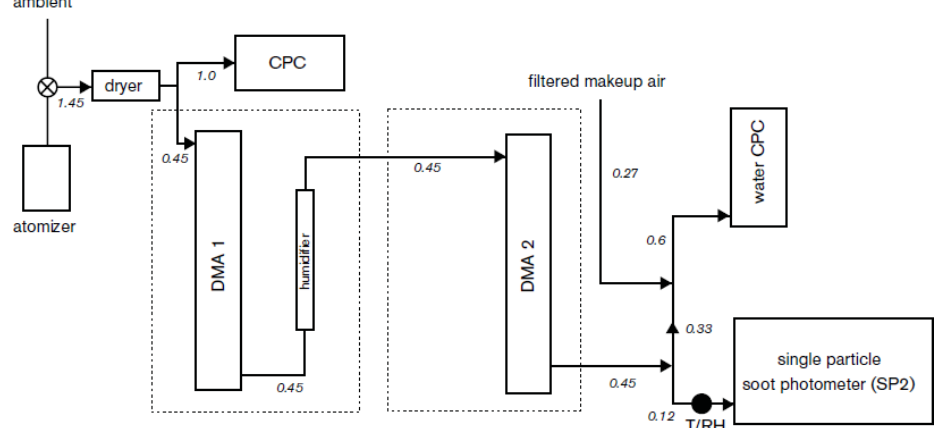
Figure 27. Schematic diagram of the H-TDMA-SP2 apparatus. Flow rates shown in this figure are in the unit of L/min. Reprint with permission by McMeeking et al.